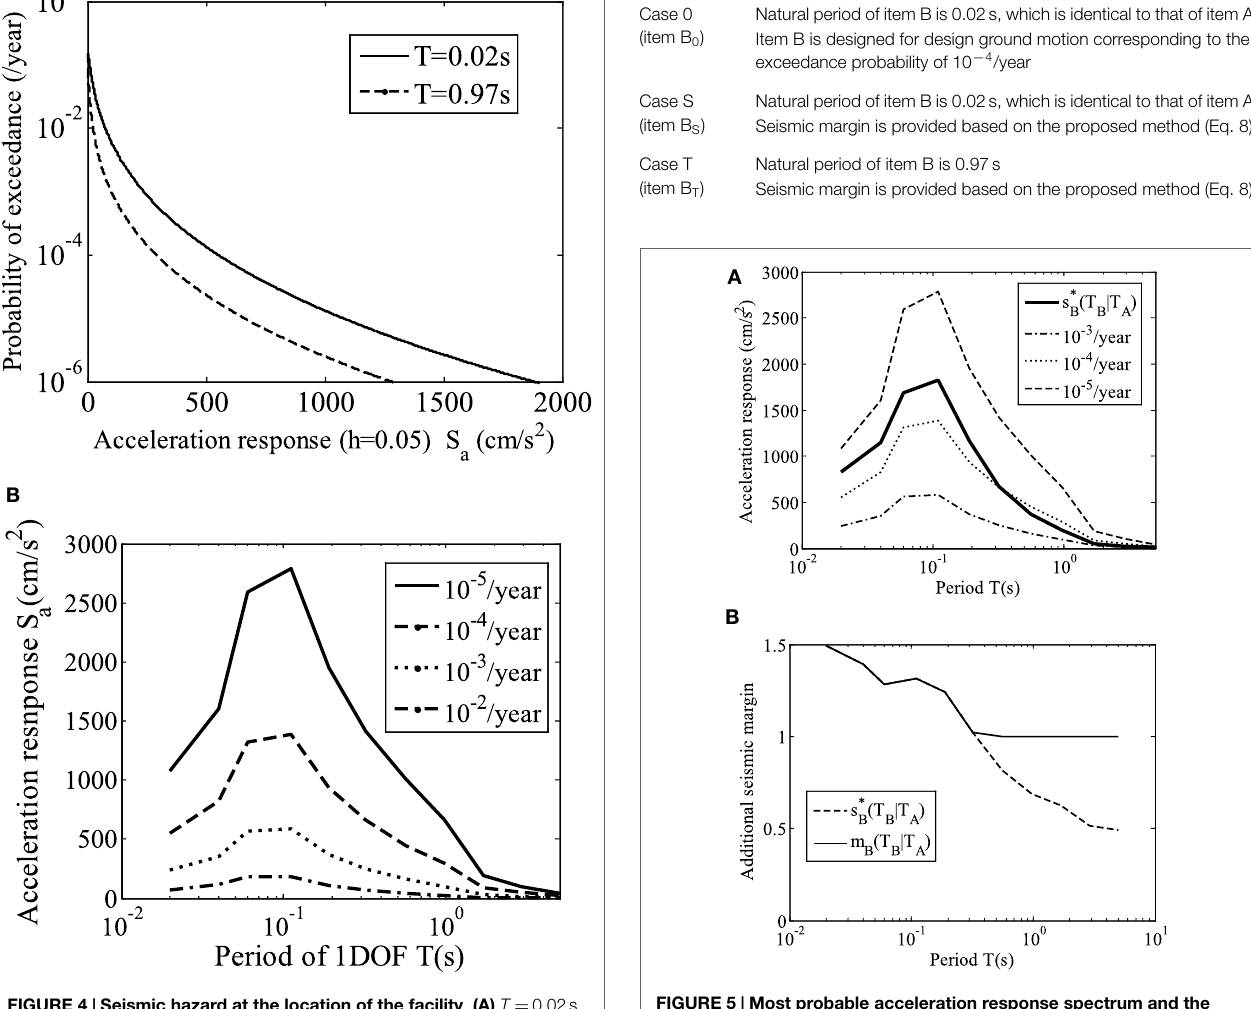
FIGURE 4 | Seismic hazard at the location of the facility . (A) T = 0.02s and T = 0.97s and (B) uniform hazard spectra. system is assumed to correspond to the exceedance probability of 10 (cid:0) 4 /year.